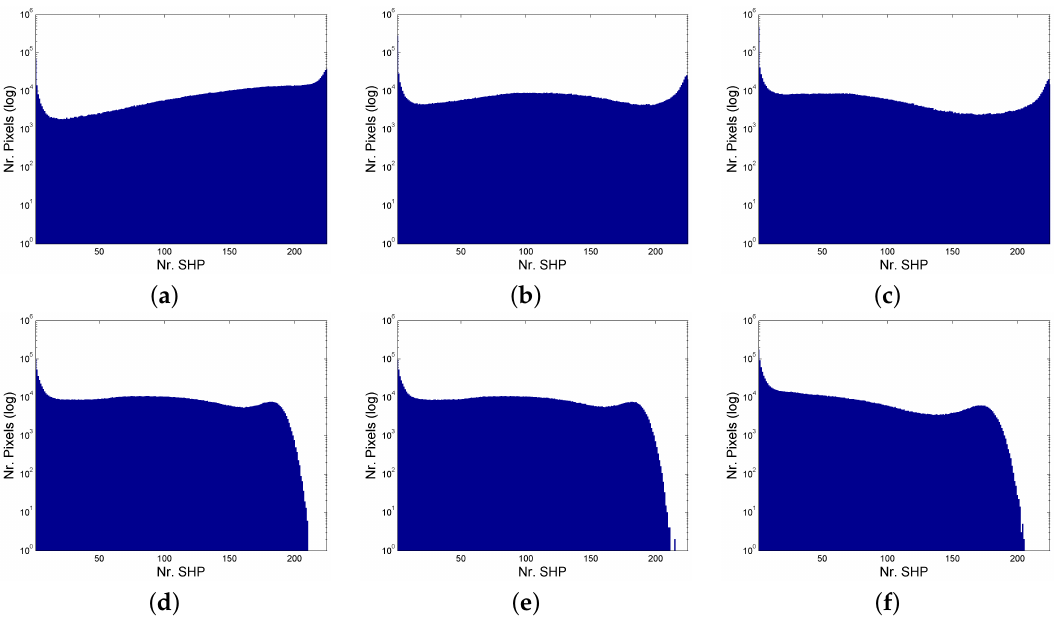
Figure 8. Histograms of the SHP number. Horizontal axis is the number of SHP based on a 15 × 15 window. Vertical axis is the pixel counts at the corresponding SHP number; ( a – f ) correspond to Figure 7a–f,